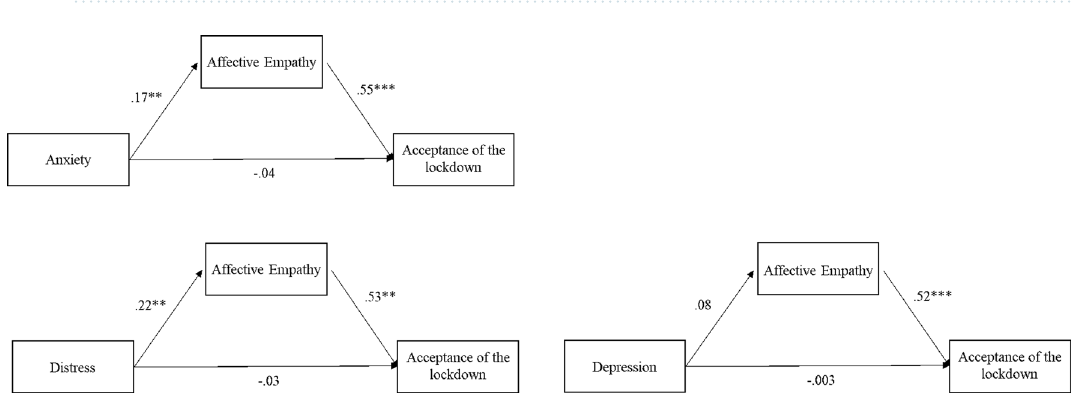
Figure 2. Mediation analyses, reverse models, Phase 1. Note: The covariates are not listed for readability purpose. * = p < .05; ** = p < .01; *** = p <